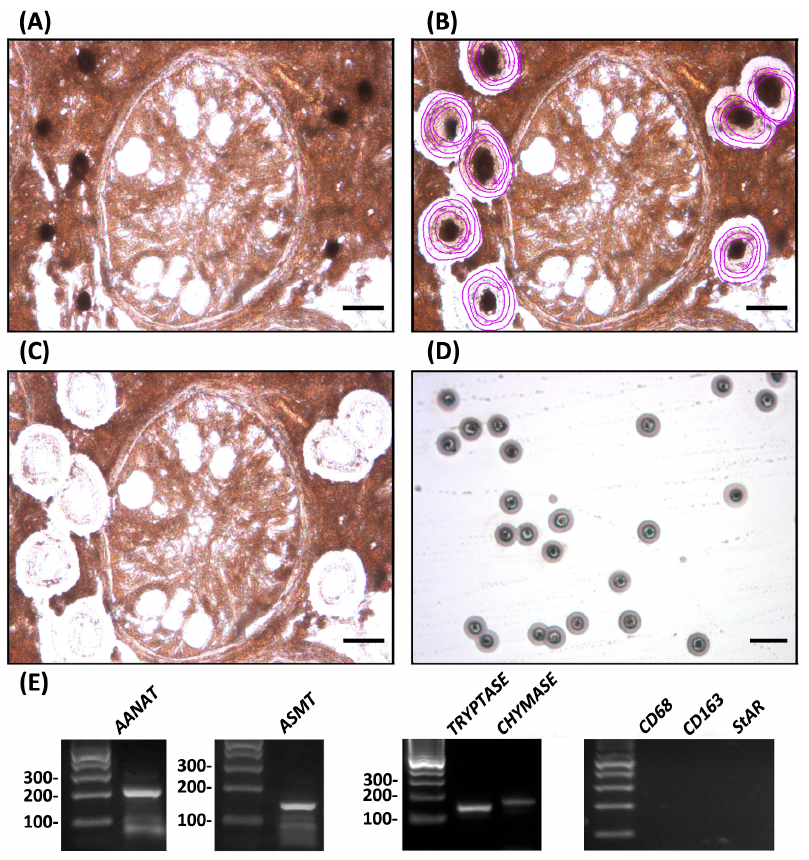
Figure 3. Using laser capture microdissection, tryptase-immunoreactive mast cells were isolated from testicular biopsies of patients suffering from hypospermatogenesis or Sertoli cell only (SCO) syndrome, and subjected to RT-PCR studies. Panels depict the same specimen before laser microdissection ( A ), after ultraviolet laser delimitation (purple circles) of tryptase-immunoreactive mast cells ( B ) and after infrared laser microdissection of target cells ( C ). Bar, 25 μ m; ( D ) depicts tryptase-immunoreactive mast cells captured into the cap of a microfuge